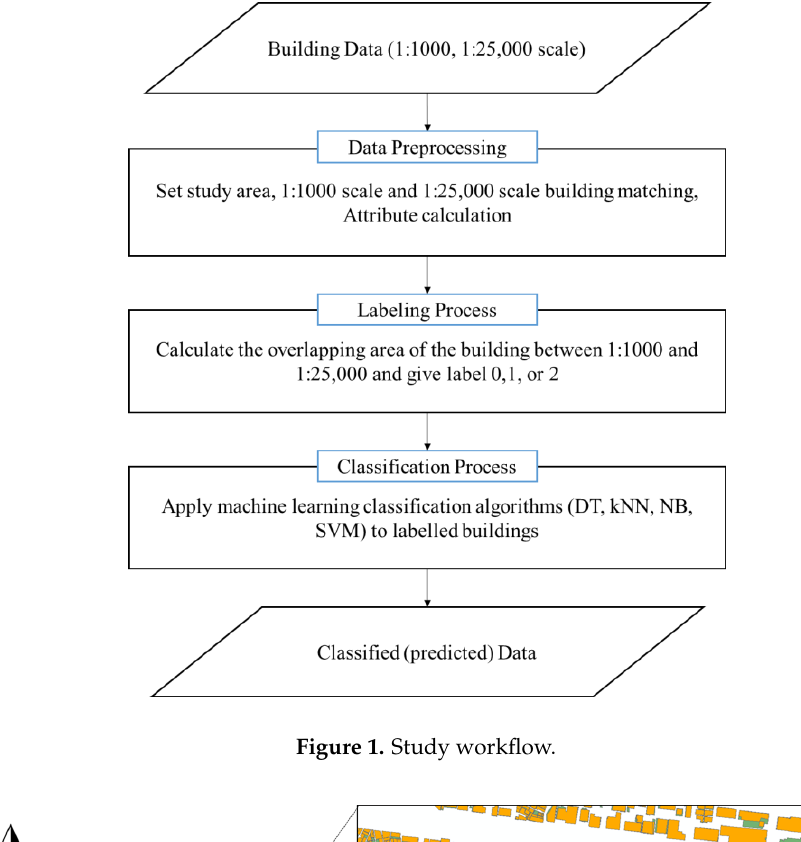
Figure 1. Study workflow.